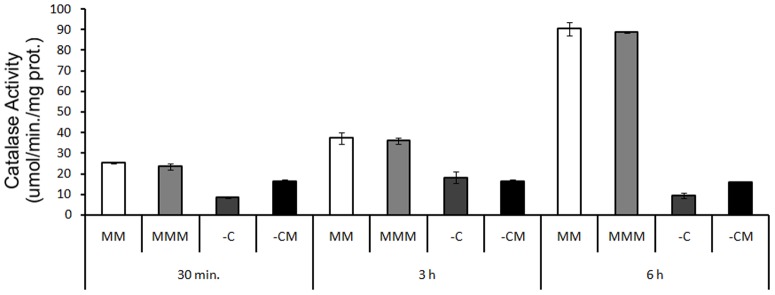
CAT activity in E. coli DH5-α in MM, and in the MMM, -C and -CM treatments, at periods of 30 min., 3 h and 6 h, respectively.LSD = 1.17 for all pairwise comparison.